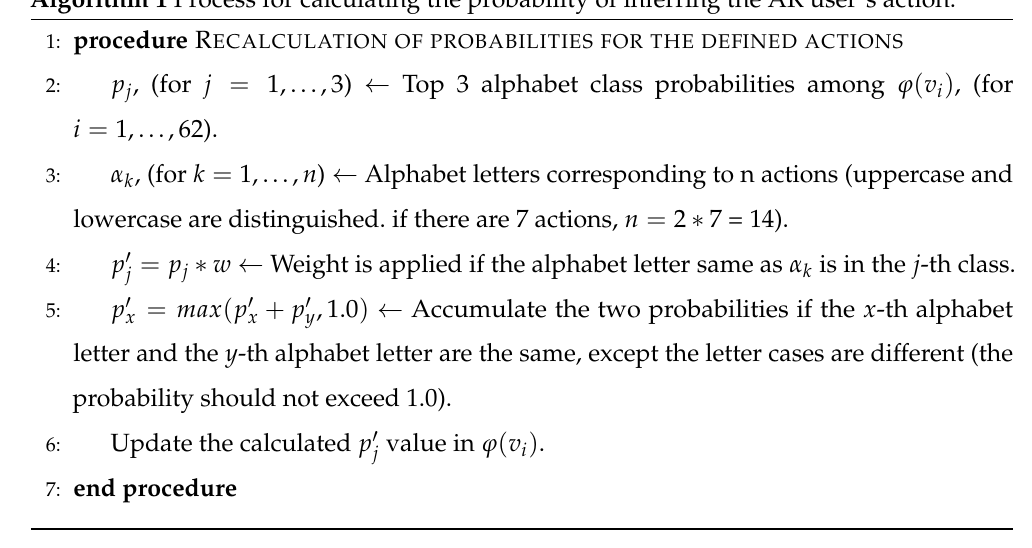
Algorithm 1 Process for calculating the probability of inferring the AR user’s